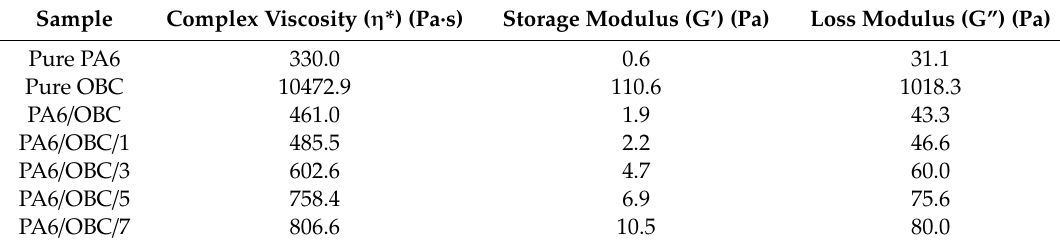
Figure 6. The complex viscosity of pure PA6, pure OBC, and the PA6 / OBC and PA6 / OBC / POE-g-MAH blends at various POE-g-MAH contents. Table 2. The complex viscosity ( η * ), storage modulus (G’), and loss modulus (G”) of pure PA6, pure OBC, and the PA6 / OBC and PA6 / OBC / POE-g-MAH blends at various POE-g-MAH contents and a frequency of 10 − 1 rad / s.